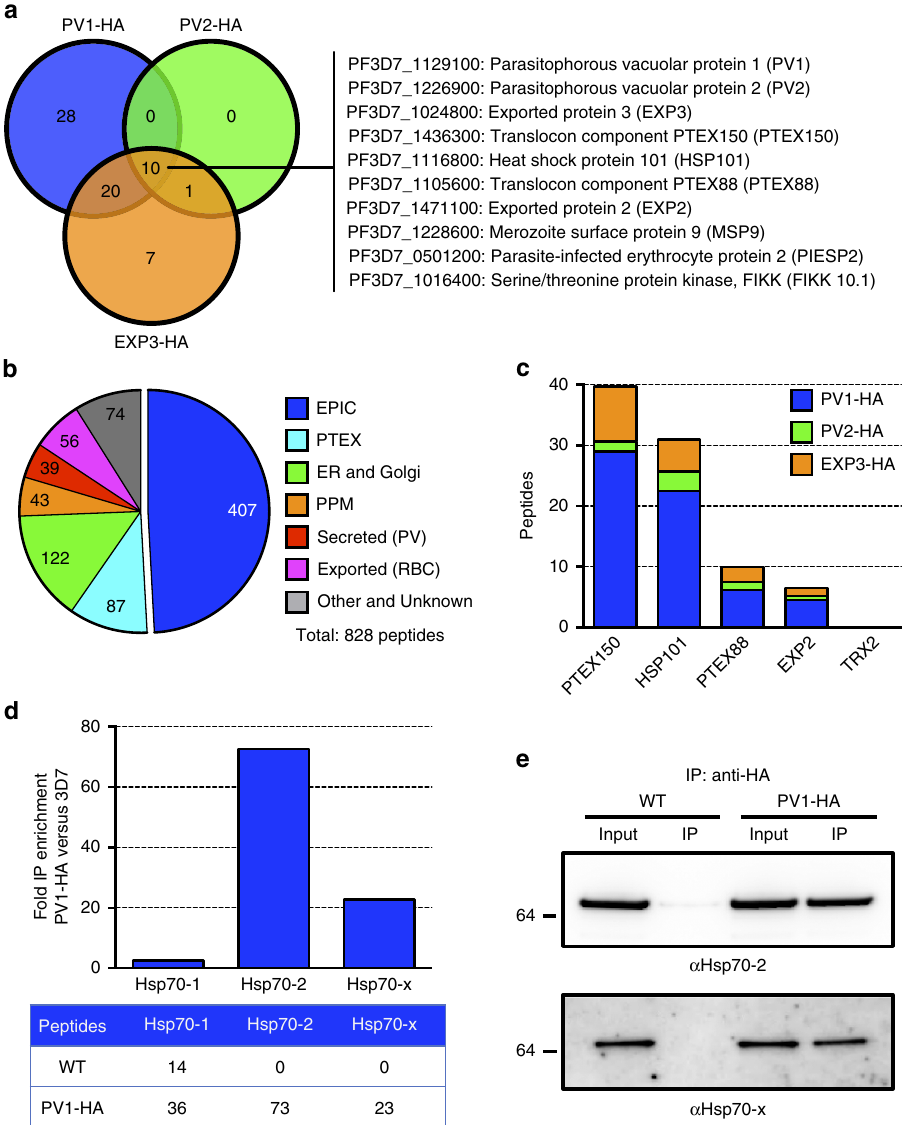
Figure 6 | Analysis of the EPIC interactome. ( a ) Venn diagram of proteins identified by tandem mass spectrometry of IPs of EPIC components (PV1-HA, PV2-HA and EXP3-HA) IPs. PlasmoDB accession numbers and names of proteins that were found to pull-down with all three bait proteins are shown. Numbers in the diagram refer to number of proteins pulled down with each bait protein. ( b ) Peptides identified by tandem mass spectrometry in EPIC component IPs sorted according to function or known localization of the parent proteins. ( c ) PTEX peptides pulled down with EPIC components. ( a – c ) Peptide numbers are based on averages from two independent experiments. All identified proteins are listed in Supplementary Tables 3–5. ( d , e ) Analysis of enrichment of Plasmodium HSP70 proteins in PV1-HA IPs. ( d ) Fold enrichment of Hsp70-1, Hsp70-2 and Hsp70-x peptides in PV1-HA IPs compared with wild type is shown. The table below shows average numbers of peptides identified from two independent experiments. ( e ) Immunoprecipitation of PV1-HA parasite lysate using anti-HA-conjugated agarose beads. Western blots of total protein (input) and IP eluate (IP) were probed with anti-HSP70-2 and anti-HSP70-x antisera. Molecular masses are shown in kDa. Uncropped western blots are shown in Supplementary Fig.